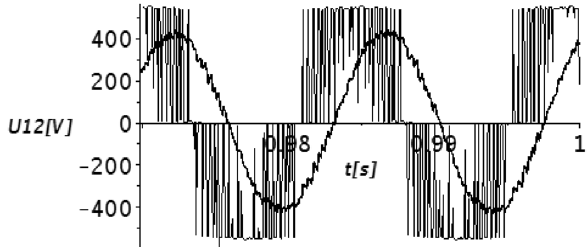
Fig. 26 Motor’s clamps voltage and phase current (multiplied by 20) at the final stage of the starting course: f v =45 (Hz), f c =72.0 (Hz), n = 1420